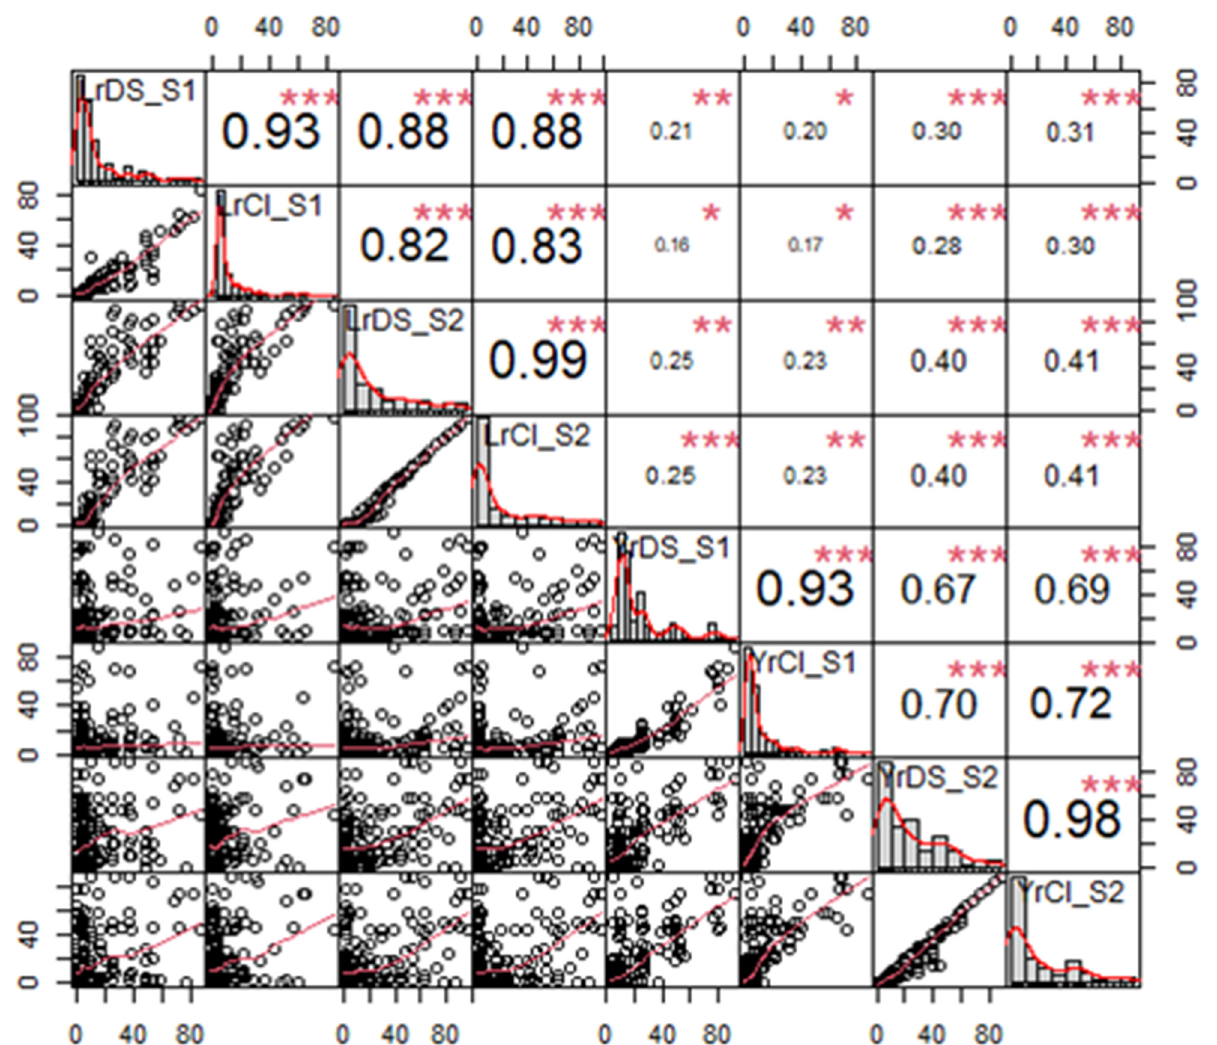
Figure 2. Correlation among disease severity (DS) and co-efficient of infection (CI) of leaf rust (LR) and yellow rust (YR) in season 1 (_S1) and season 2 (_S2). *, ** and *** indicated significance at 0.05, 0.01 and 0.001 p -value, respectively .